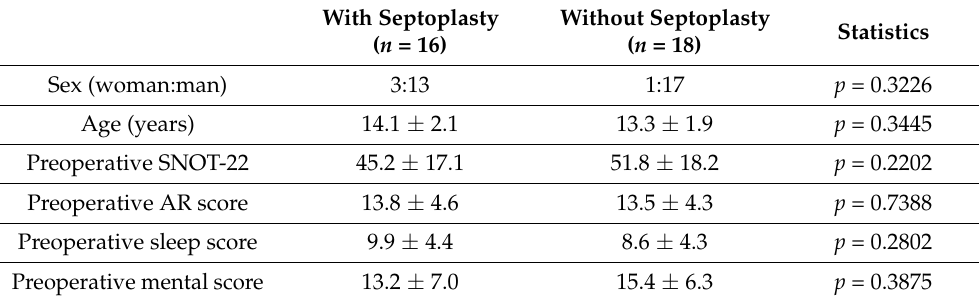
Table 2. Demographic characteristics and preoperative scores in subjects showing sleep and mental disorders with or without septoplasty. With Septoplasty Without Septoplasty Statistics ( n = 16)